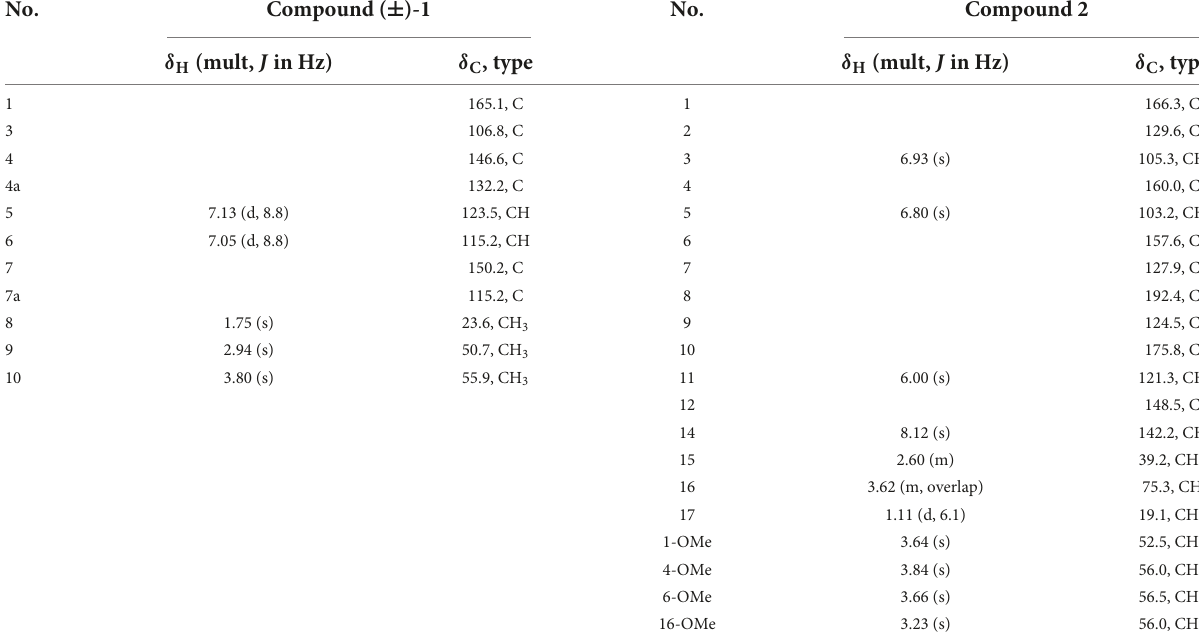
TABLE 1 NMR data for compounds ( ± )- 1 and 2 in DMSO- d 6 ( 1 H at 500 MHz and 13 C at 125 MHz).